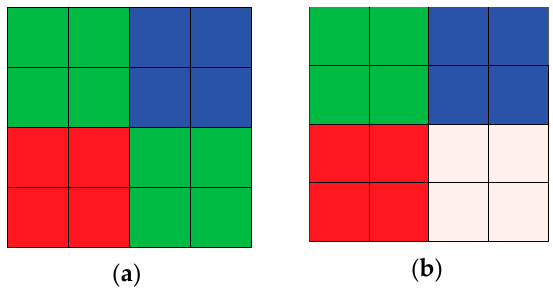
Figure 1. Color filter arrays in 8 × 8 pixels: ( a ) Quad-Bayer array; ( b ) Quad-WRGB array. The same color filter is arranged in 2 × 2 pixels.